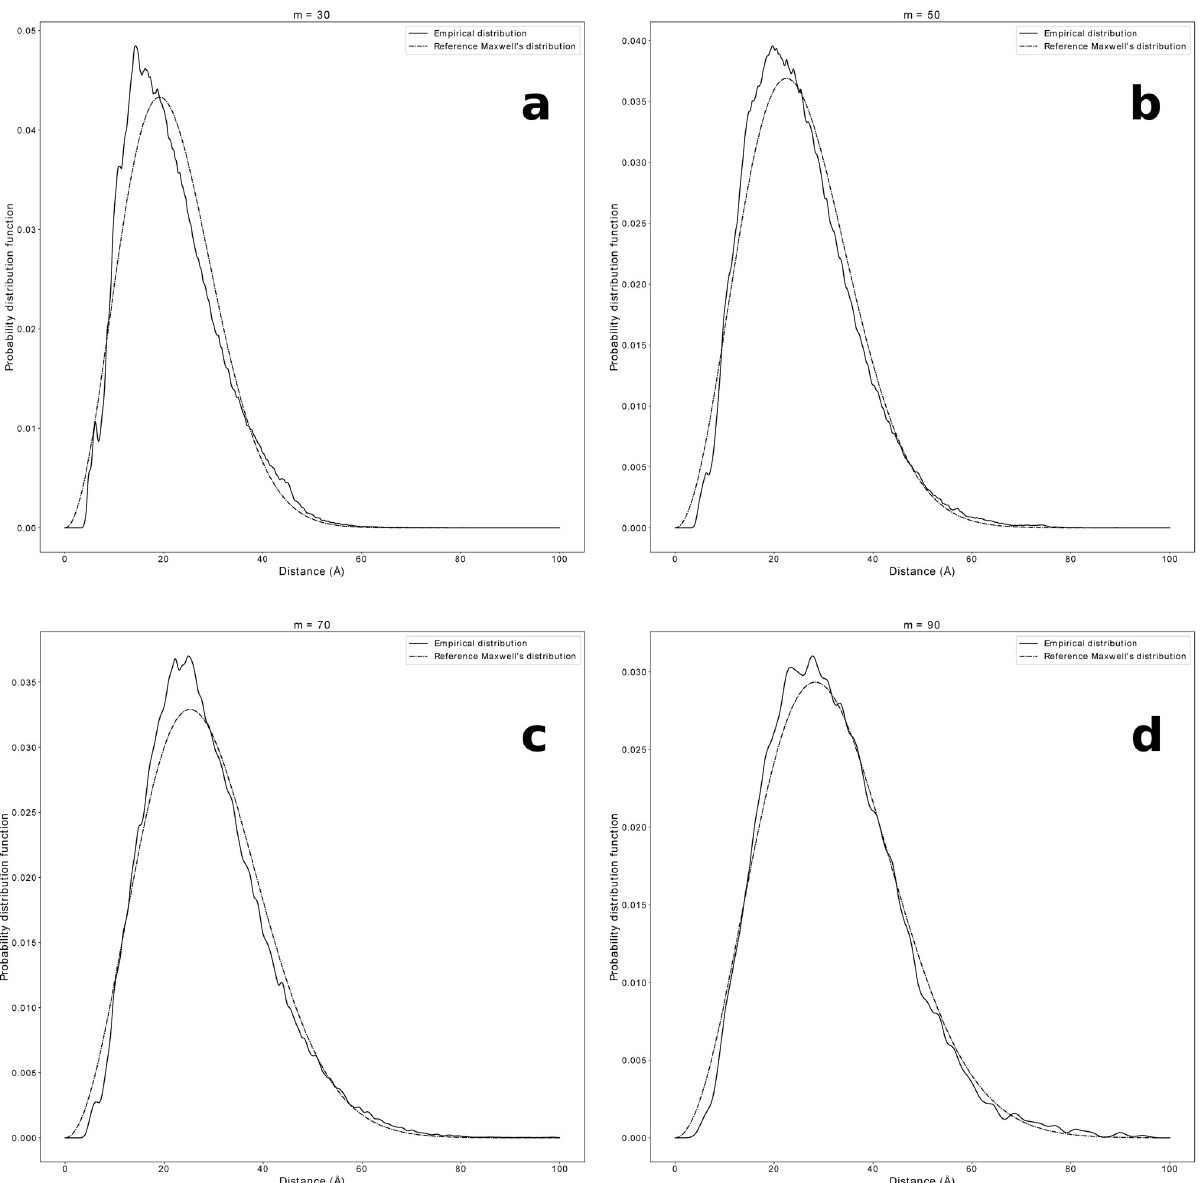
Fig 2. Gaussian statistics for buried fragments: End-to-end distance. The CA end-to-end distance probability distributions for four different fragment lengths, ( a ) m = 30, ( b ) m = 50, ( c ) m = 70, ( d ) m = 90, are shown together with their best fits to the Maxwell distribution (8). The parameters b used in the plots are obtained maximizing the likelihood that the empirical data belong to the Maxwell distribution (8). The value of b decreases with m and reaches a plateau for 70 � m � 90, corresponding to the Flory regime (see Fig 1b). Figure drawn with python package matplotlib, version 3.4.1. URL https://pypi.org/project/matplotlib/.